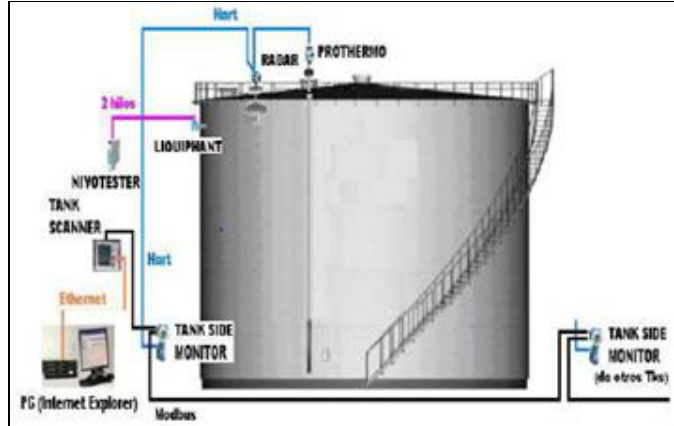
Figura 1: Configuración del sistema de automatización TankVision. Fuente: Los Autores,